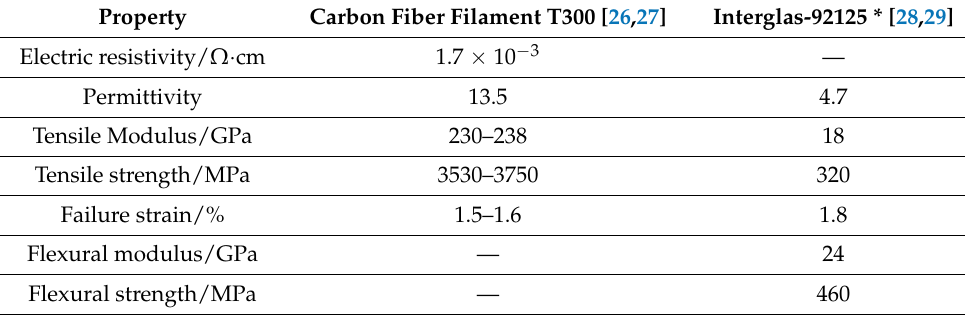
Table 1. Electrical and mechanical properties. (*) Indicates properties value of the weft